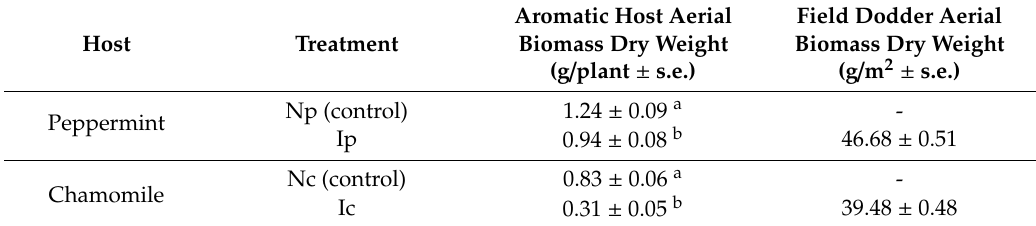
Table 1. Aerial dry weight biomass of aromatic plants and field dodder.